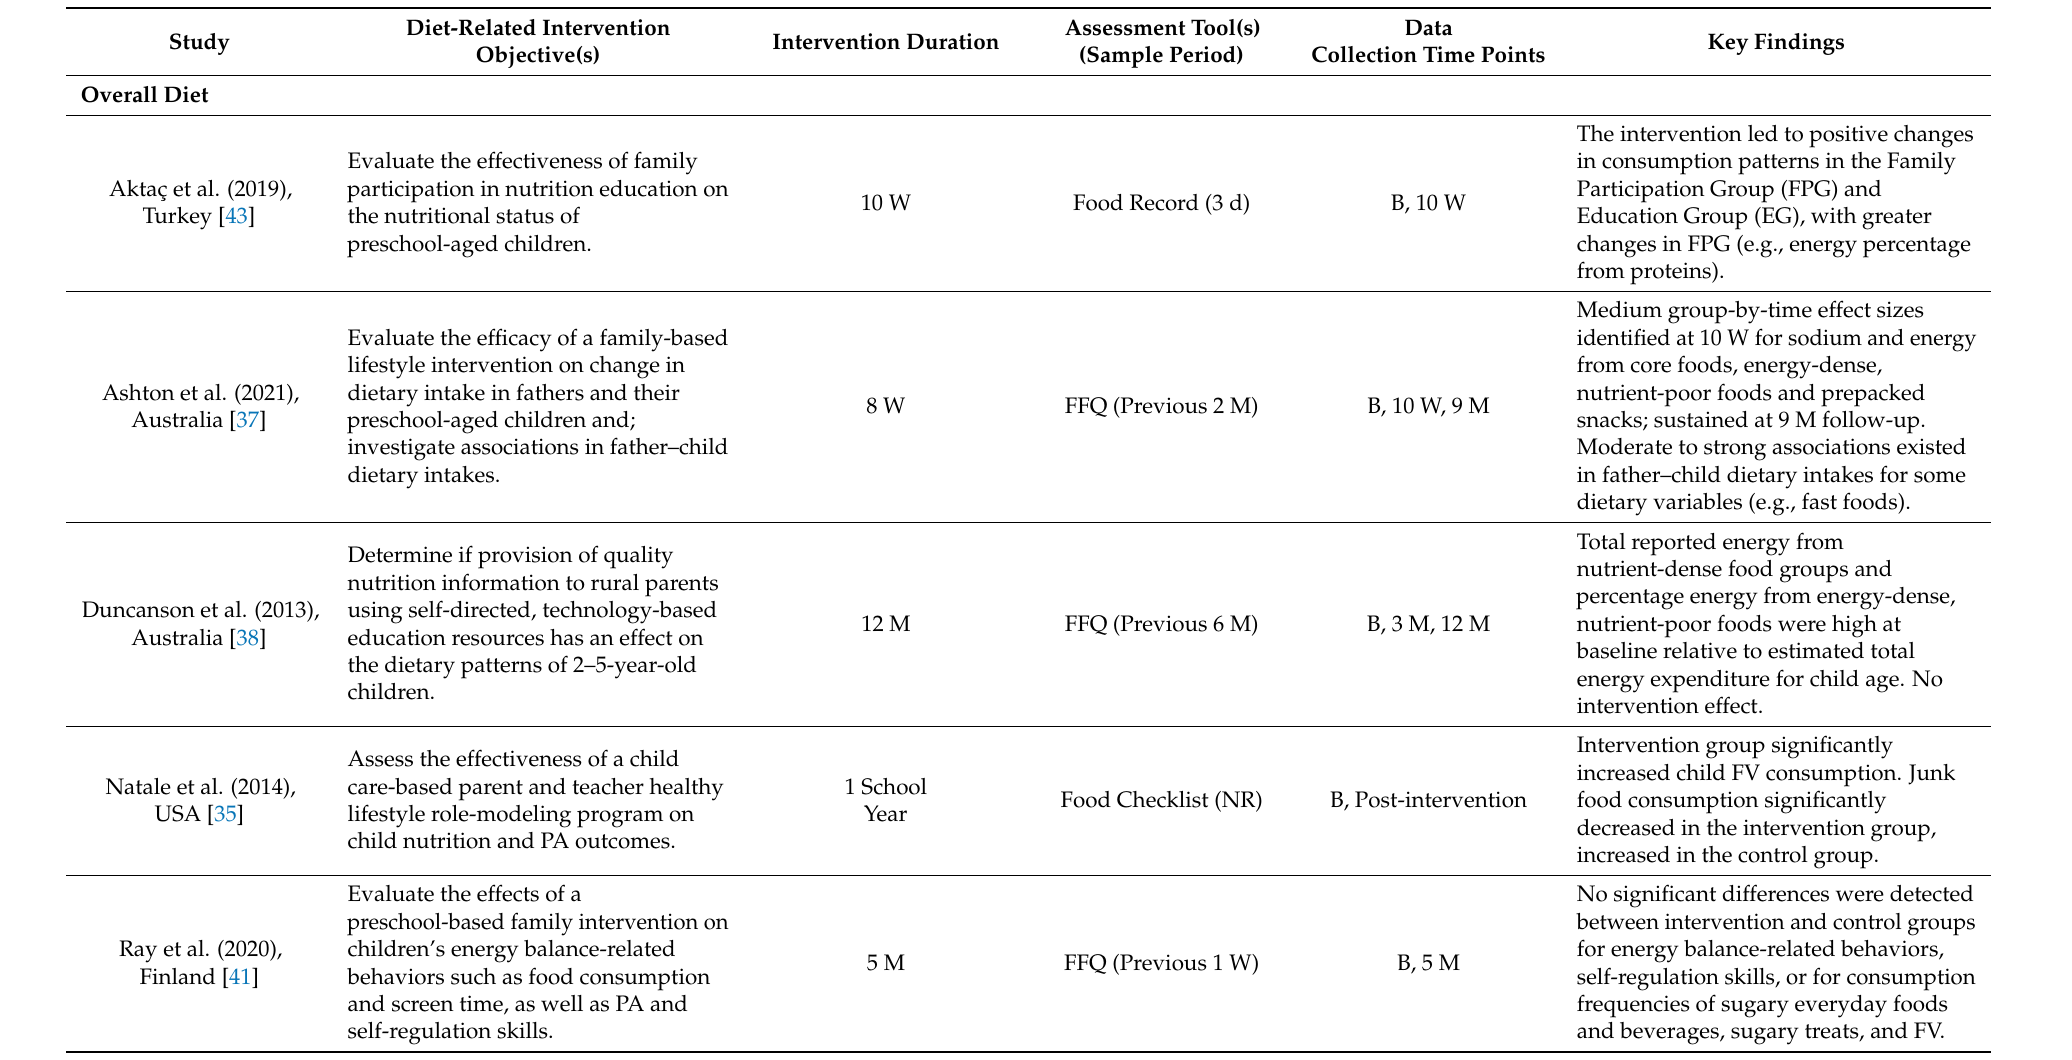
Table 3. Application of dietary assessment tools to address intervention study objectives related to young children’s diet ( n =